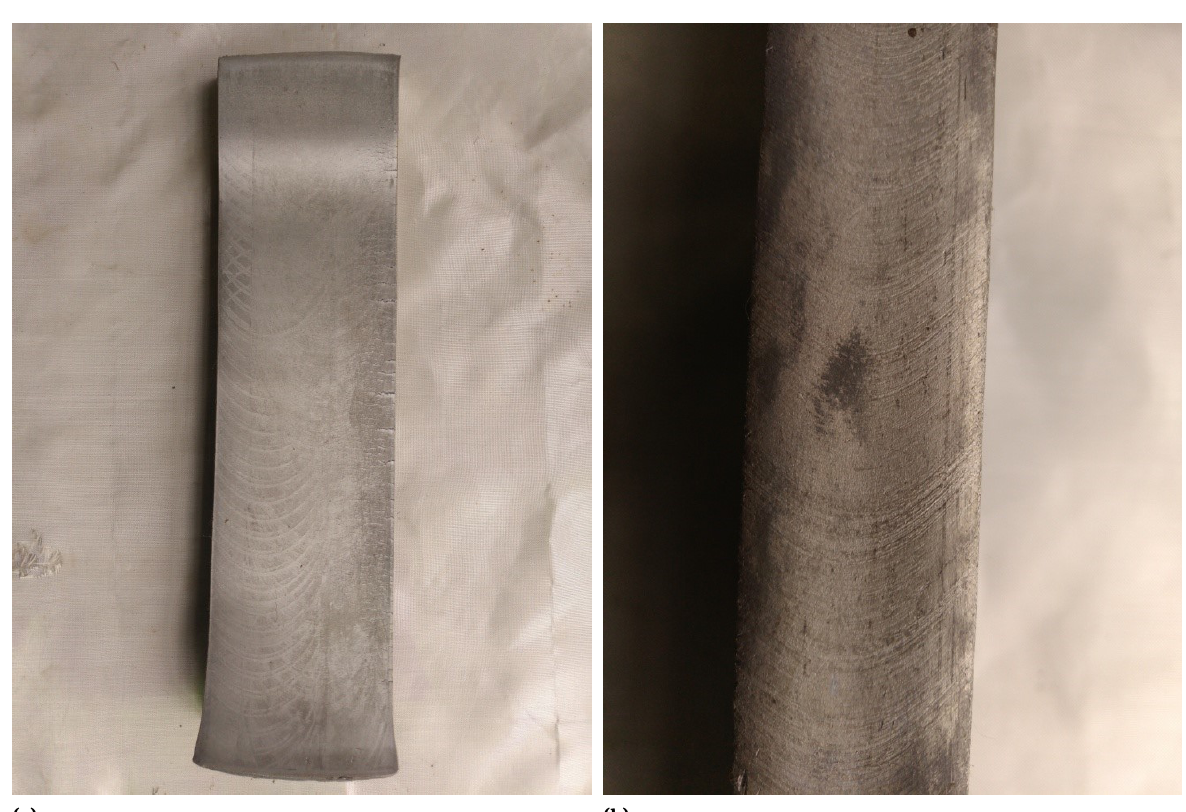
Figure 5: View of the second billet after rolling: a - from above; b - on the